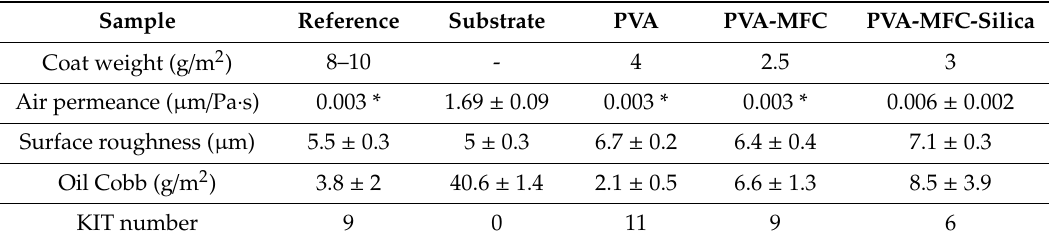
Table 2. Coat weights and barrier properties obtained with di ff erent formulations.